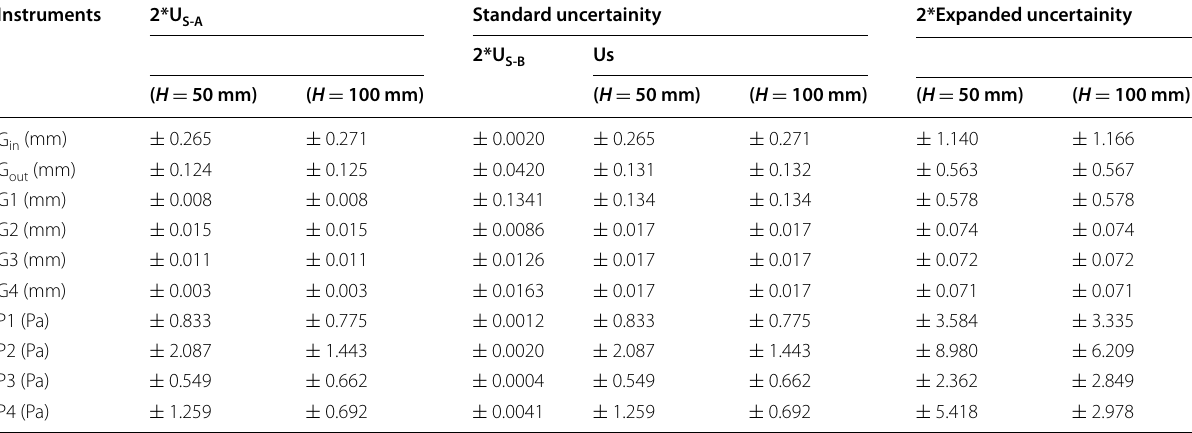
100 mm, T 1.2 s and a constant = = 1.34 =